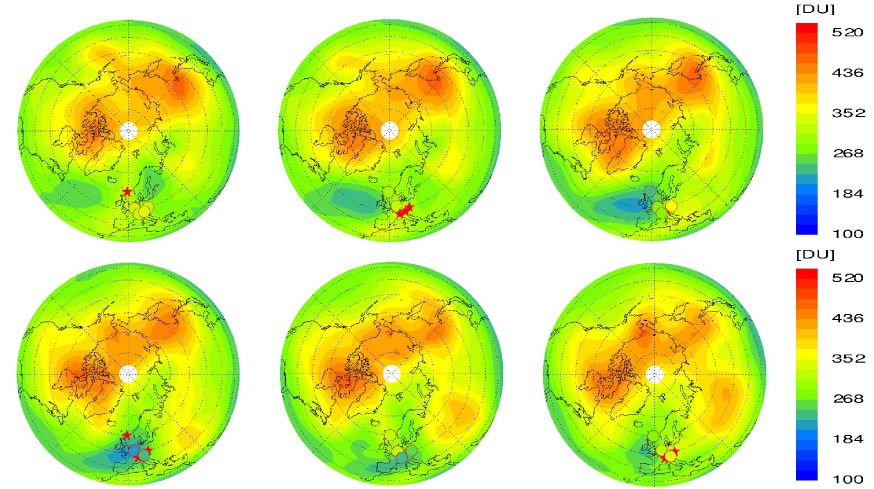
Fig. 8. Total ozone column in DU for 16 to 18 (top row) and 19 to 21 (bottom row) January 2006, 12:00UT, simulated by KASIMA; sounding stations are marked either by red stars (no measurement) or by red circles (total column measurement available, circles filled in respective colour code for Dobson